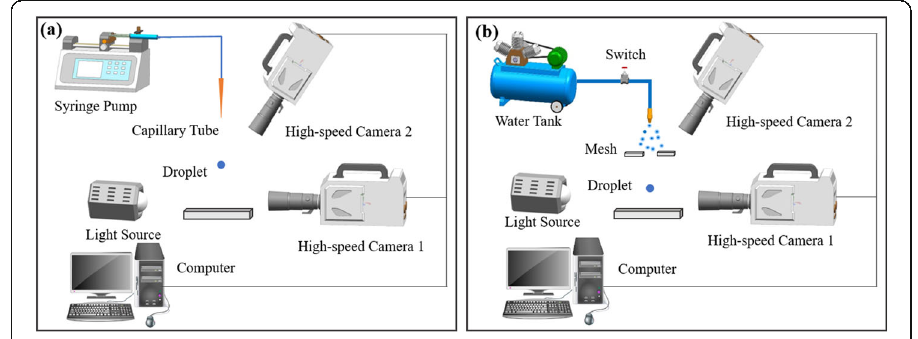
Fig. 1 Schematic diagram of the experimental setup: a Droplets are generated by a thin capillary tube connected with a syringe pump; b Droplets are atomized by a high-pressure water tank and nozzles of different